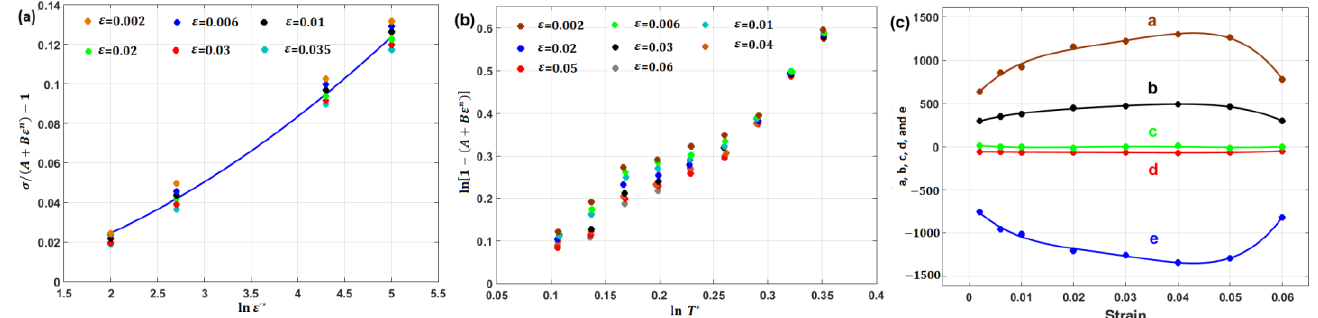
Figure 37. Determination of constants ( a ) 𝐶 1 and 𝐶 2 ; ( b ) different values of a, b, c, d, and d at different strains; ( c ) fitting a, b, c, d, and d as functions of strain.